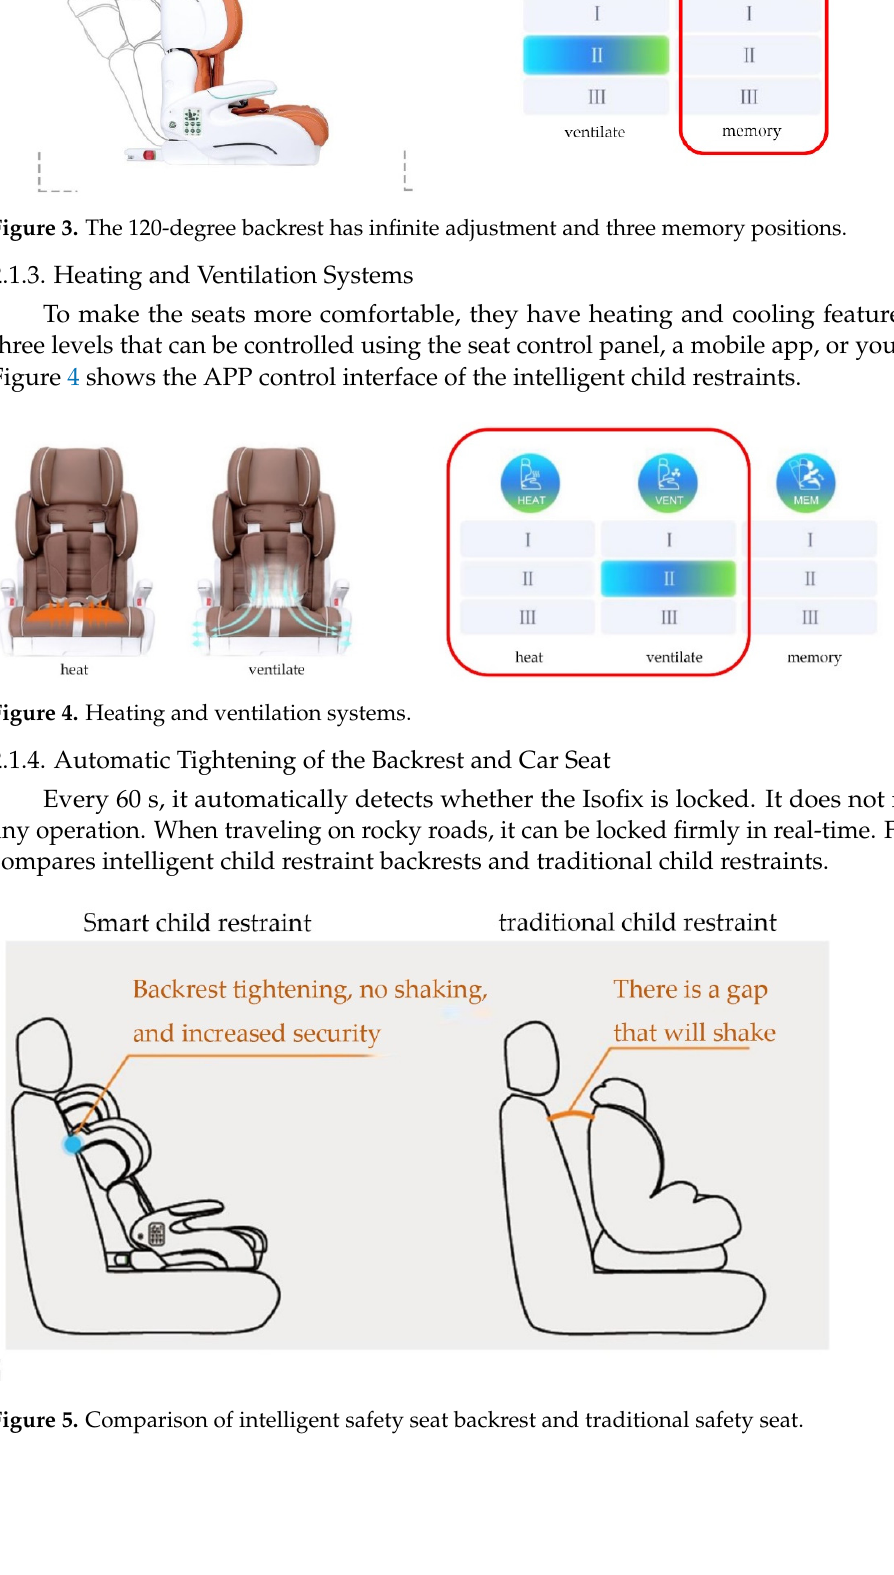
of the seat backrest that can be stored via memory keys.